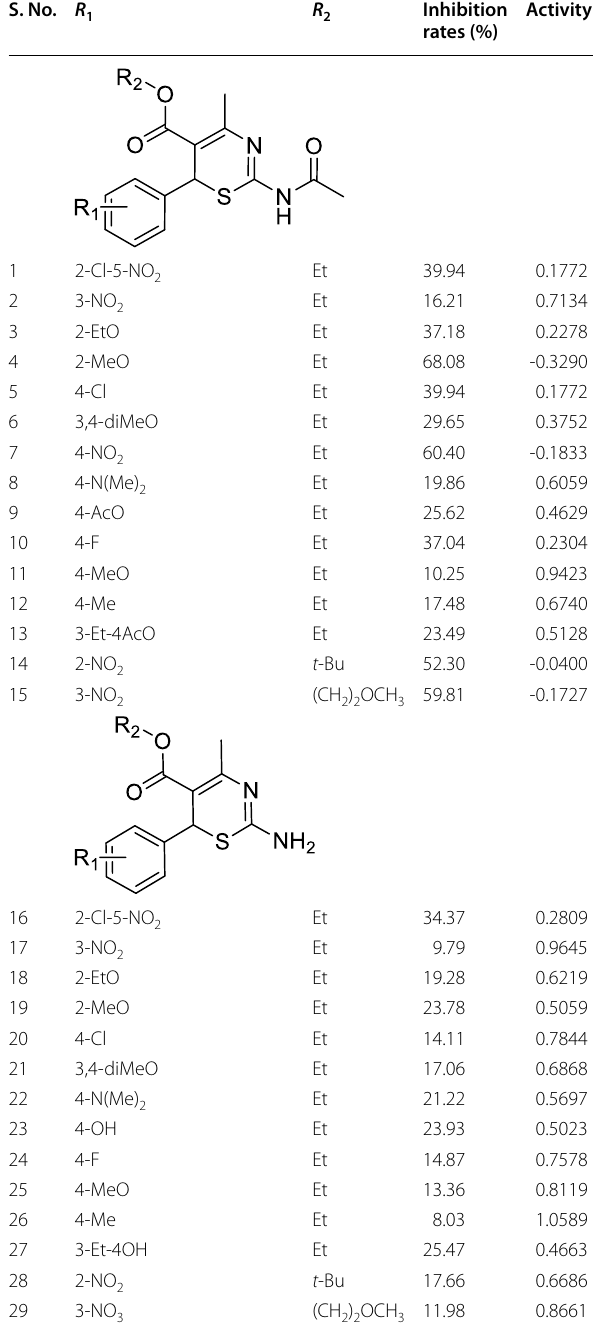
Table 1 Substitution arrangement of 1,3-thiazine derivatives along with their NA inhibitory